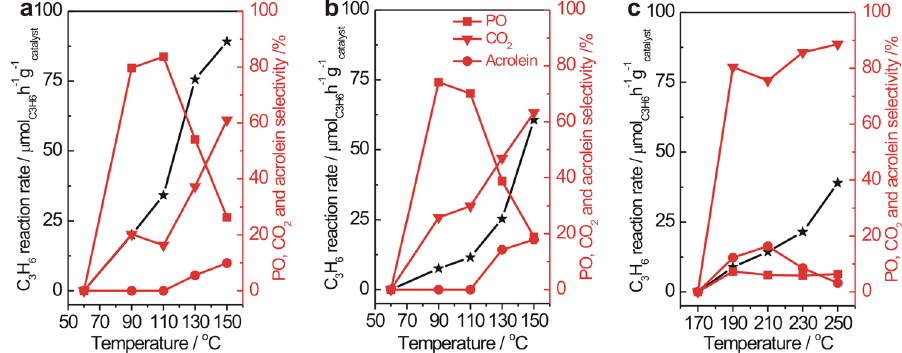
Fig. 2 Catalytic performance in C 3 H 6 oxidation with O 2 . C 3 H 6 reaction rate (black) and propylene oxide (PO), acrolein, and CO 2 selectivities (red) of the C 3 H 6 oxidation with O 2 catalyzed by a c-Cu 2 O-27, b c-Cu 2 O-106, and c c-Cu 2 O-774 NCs. Reaction condition: 200 mg catalyst, 8% C 3 H 6 , and 4% O 2 balanced with Ar at a fl ow rate of 50 mL min − 1 spectroscopic (Supplementary Fig. 8) characterization results resulting from surface oxidation were observed to locate show that the structures of spent c-Cu 2 O-27 and c-Cu 2 O-106 preferentially at the edges, supporting that the Cu 2 O{110} edge NCs at 90 °C and spent d-Cu 2 O-439 at 210 °C are similar to their sites are where the catalytic reactions dominantly occur. In-situ starting structures, whereas the surfaces of spent c-Cu 2 O-27 and NAP-XPS spectra of c-Cu 2 O-27 NCs under 0.6 mbar C 3 H 6 + 0.3 c-Cu 2 O-106 NCs at 150 °C and spent c-Cu 2 O-774 NCs at 210 °C mbar O 2 (Supplementary Fig. 9) do not show obvious surface get oxidized, which can be associated with the selective CO 2 oxidation at temperatures up to 150 °C. The discrepancy on surface oxidation of c-Cu 2 O-27 NCs at 150 °C under catalytic production, a highly exothermic reaction. Surface oxidation is more extensive on fi ner c-Cu 2 O-27 NCs than on c-Cu 2 O-106 reaction and NAP-XPS measurement conditions can be attrib- NCs. CuO ad-particles on spent c-Cu 2 O-27 and c-Cu 2 O-106 NCs uted to the existing pressure gap.